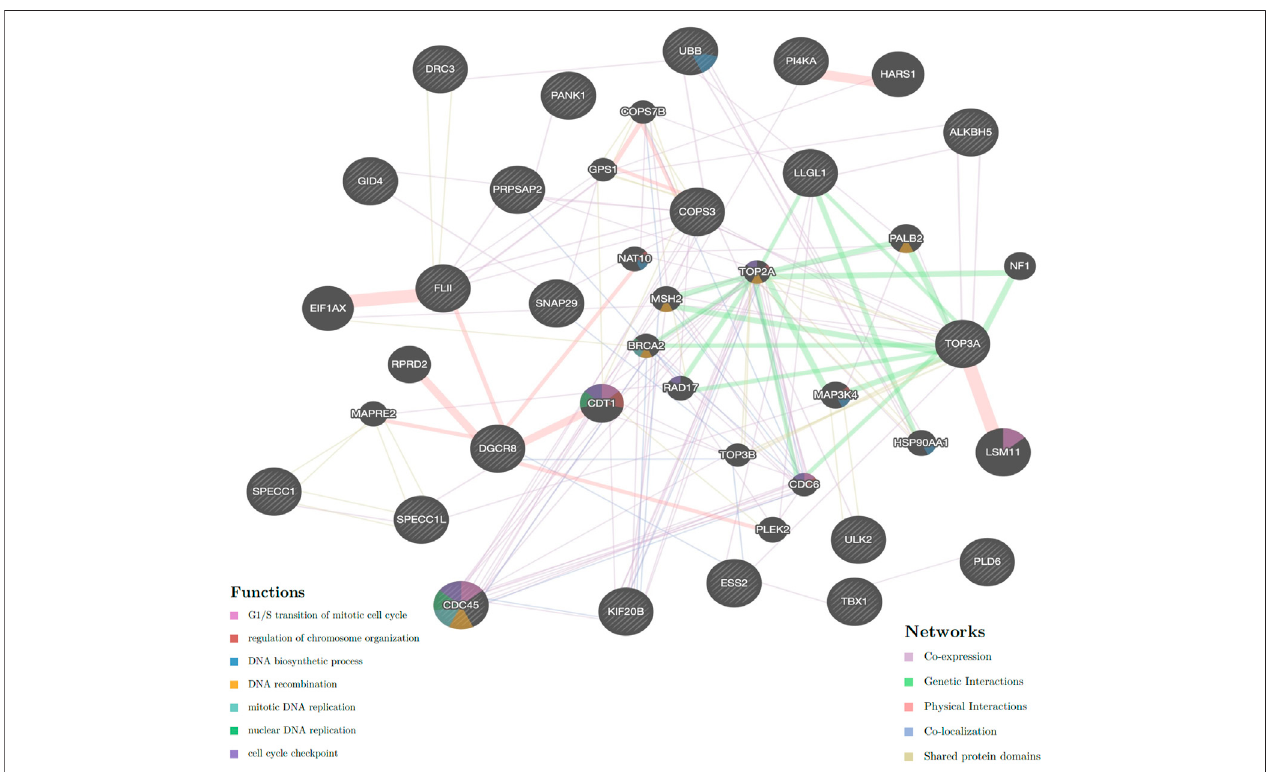
FIGURE4| Networkofgeneslocatedonthebreakpointsoftranslocationandmicroduplication(availablefromGeneMANIA).Circleswithagraydiagonalarethe21 genesinbreakpoints;blackcirclesarethe20related genes;3genes(FLJ37201, LINC00865andCCDC144NL-AS1)arefoundnointeractionwiththesegenes.Genetic linkages are drawn with different colors of lines, and the functions of these genes are present in color within circles. It has shown that genes of KIF20B, TOP3A, LLGL1 PRPSAP2, and CDC45 were closely associated with TOP2A expression, which has been found to be associated with the defective morphology of sperm heads.